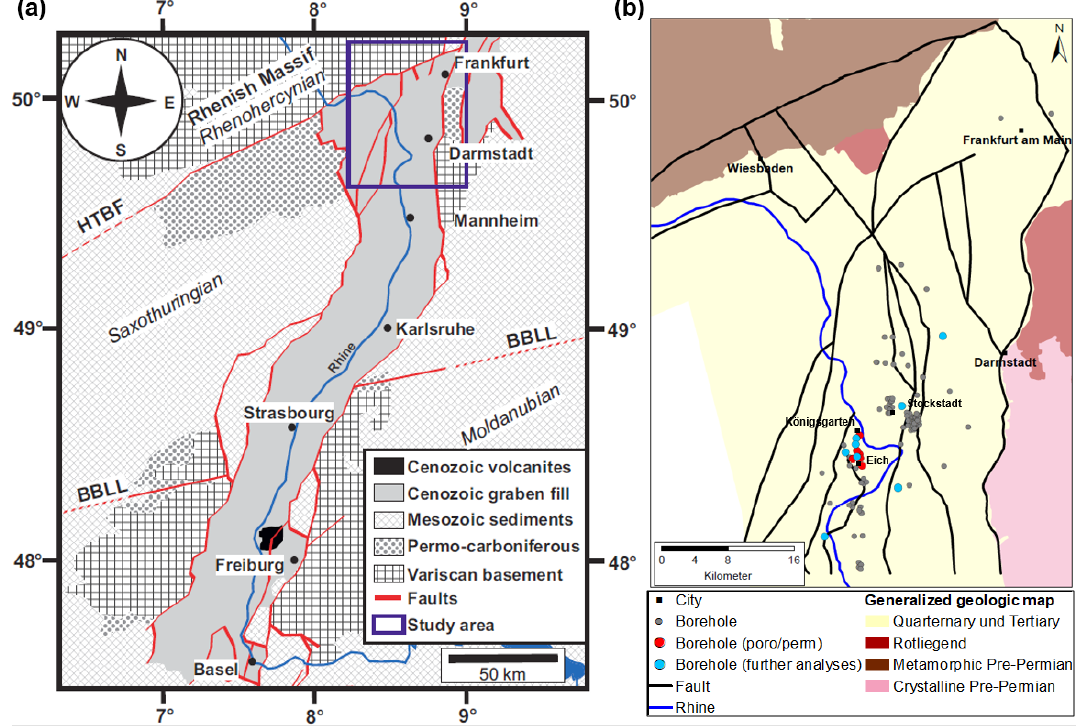
Figure 1. (a) Geological overview of the Upper Rhine Graben (HTBF: Hunsrück-Taunus Boundary Fault; BBLL: Baden-Baden-Lalaye- Lubine Fault), modified after Schwarz (2006). (b) Study area with location of boreholes (16 boreholes with porosity and permeability data (red and blue), from which eight boreholes were chosen for further petrophysical analyses (blue)). The location of major faults is shown at